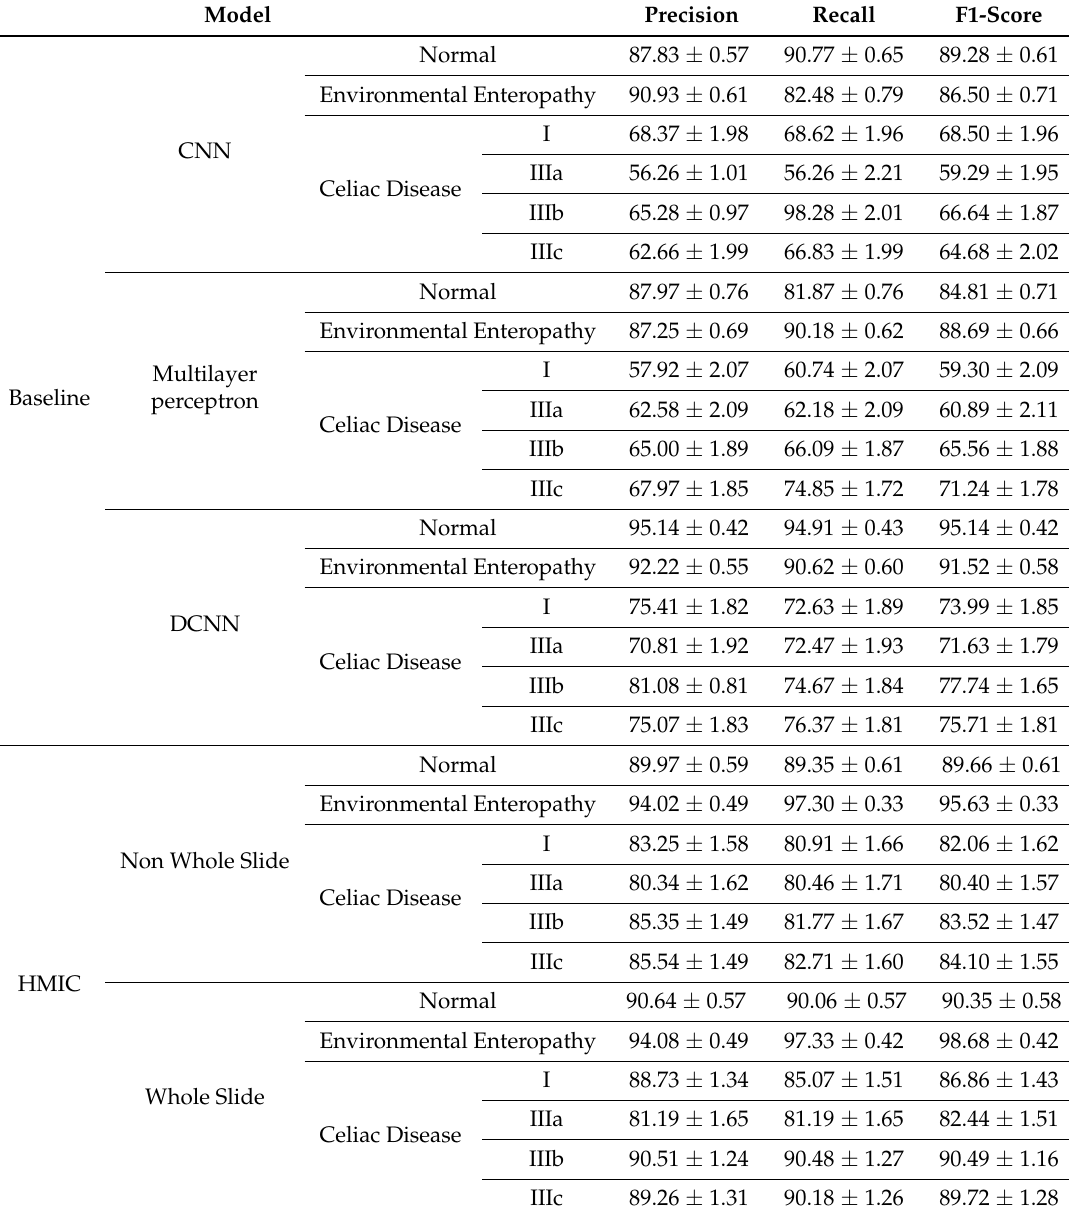
Table 5. Results per-classed of HMIC with comparison with our